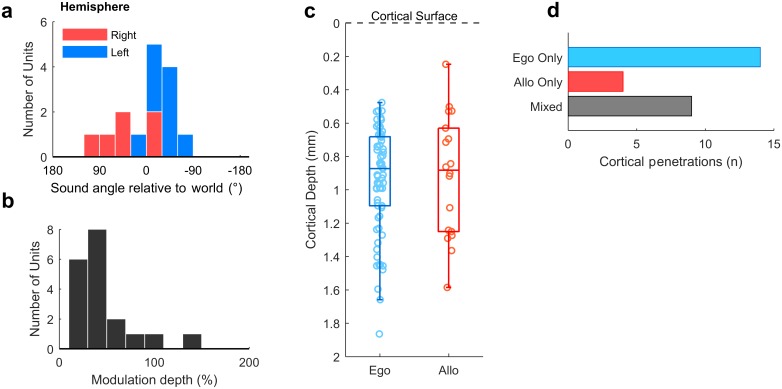
Allocentric unit characteristics.a: Preferred location of all allocentric units (n = 19) in left and right auditory cortex. b: Modulation depth calculated across 180° for units in both hemispheres. c: Comparison of cortical depth at which egocentric and allocentric units were recorded. Ferret auditory cortex varies in thickness between 1.5 mm and 2 mm, and electrode depths were confirmed histologically (S2 Fig). d: Number of cortical penetrations on which we recorded only egocentric units, only allocentric units, or a combination of both (mixed). All 92 spatially tuned units were recorded on 27 unique electrodes, with recorded units being distributed throughout cortex as the electrodes were descended. Data available at https://doi.org/10.6084/m9.figshare.4955369.v1.